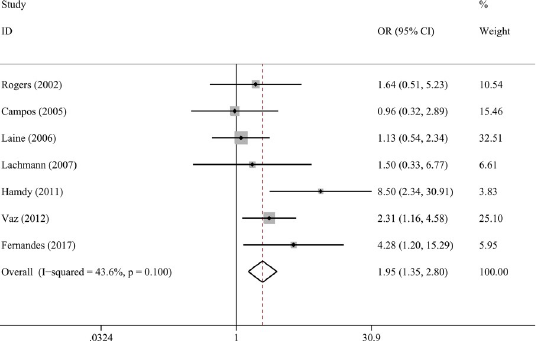
Fig 6. Forest plots of composite genotype of IL-1 α C-889T and IL-1 β C+3954T with peri-implant disease risk.